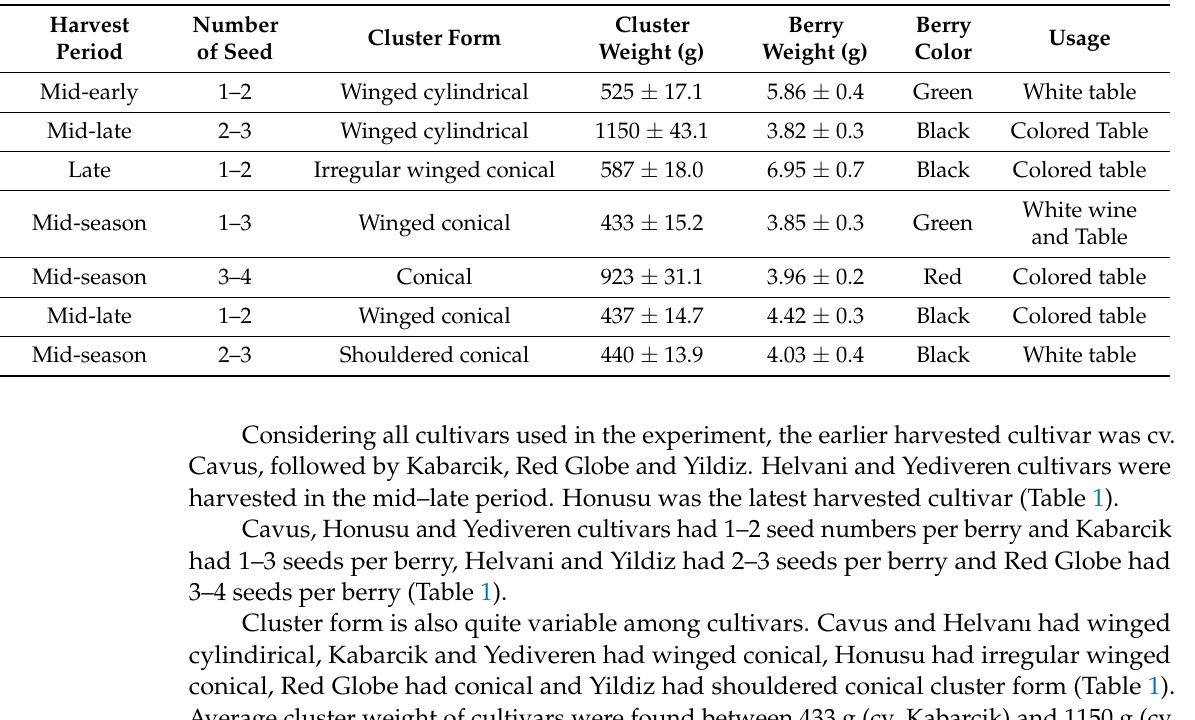
Table 1. Some morphological traits of used grape